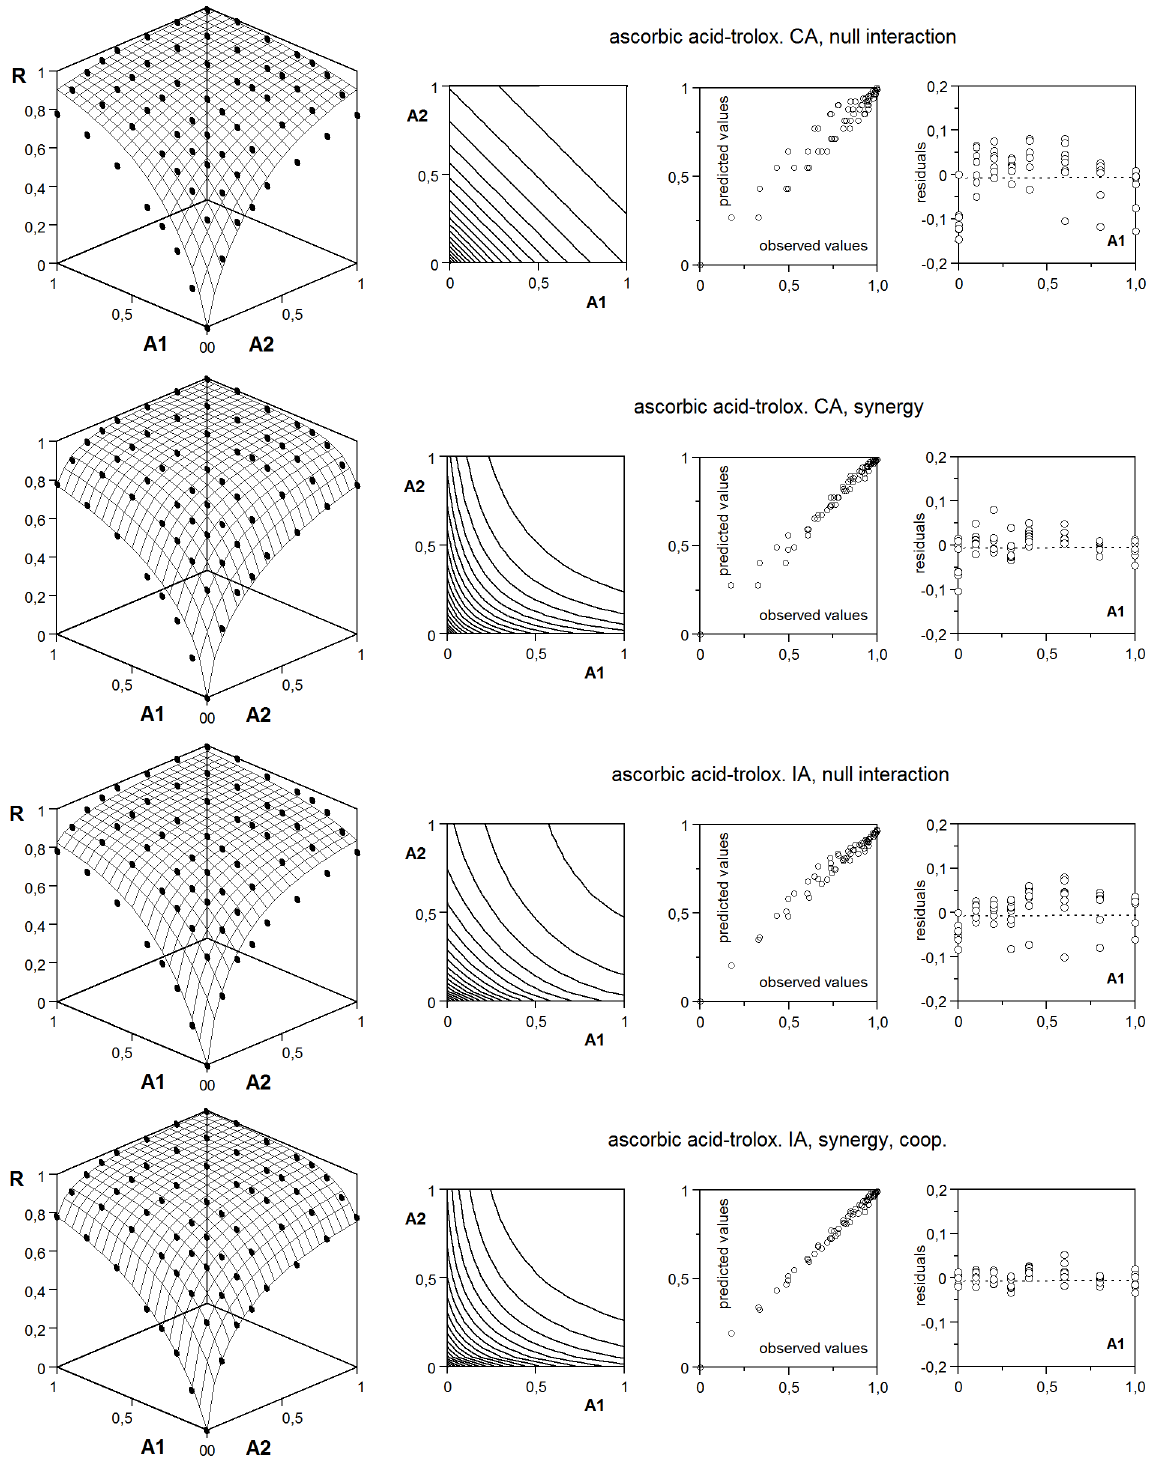
Figure 11. Joint effect of ascorbic acid (A 1 ) and trolox (A 2 ) on crocin oxidation under different hypotheses. Keys and graphic criteria as in Figure 6, with parametrtic variations replaced by residuals, which are more informative in this case. See details in text, and numerical results in.